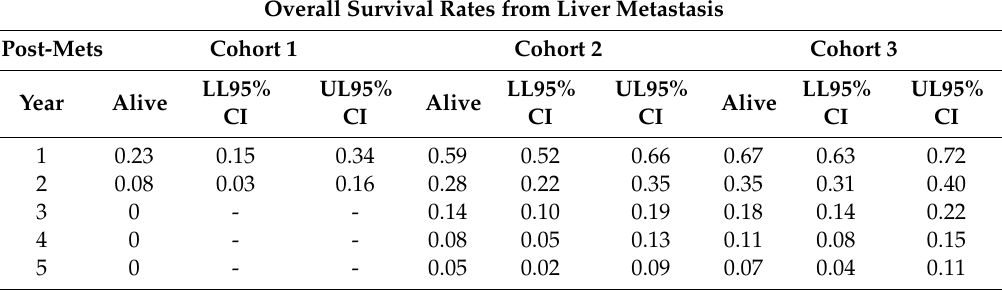
Table 3. Overall survival rates by cohort.